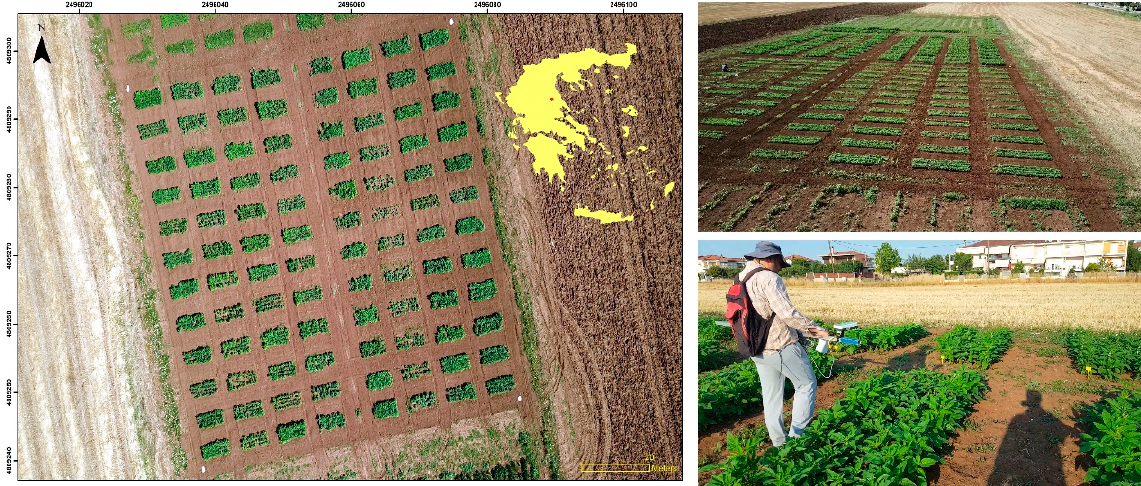
Figure 2. Location map of the research area ( left ). Plots of sesame, late planting at the front and normal at the back ( Right , above ). Sesame phenotyping with proximity sensor ( Right , below